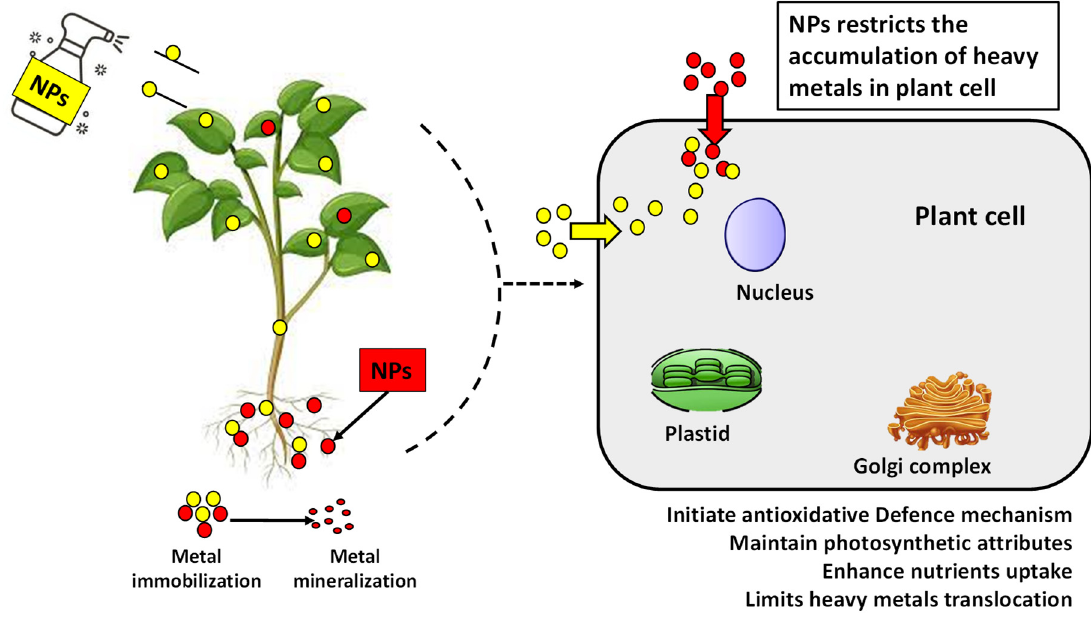
Figure 4. Interaction mechanism between NPs and heavy metals to mitigate heavy metal stress by reducing translocation in plants.